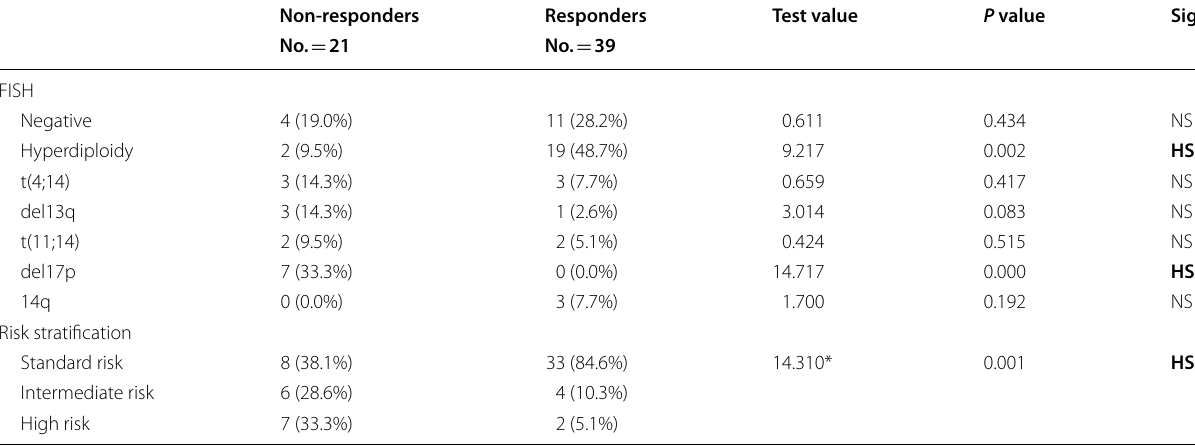
FISH fluorescence in situ hybridization *Chi‑square